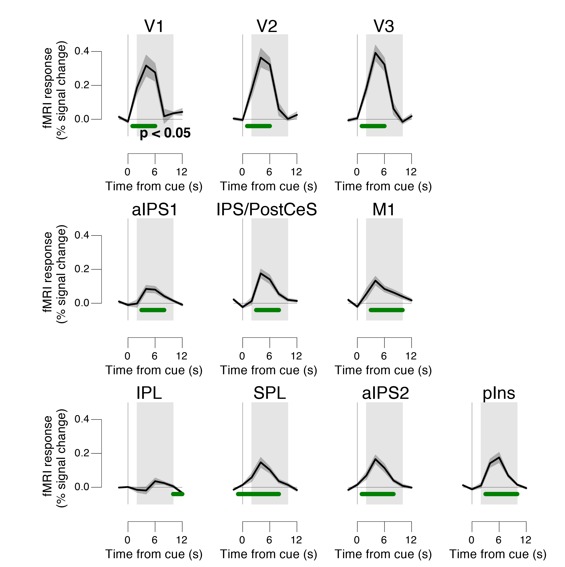
Task-evoked responses across all trials.Regions of interest were pooled across hemispheres. Green bar, time course significantly different from zero (p < 0.05; cluster-corrected). Grey box, time window for computing scalar response amplitudes.